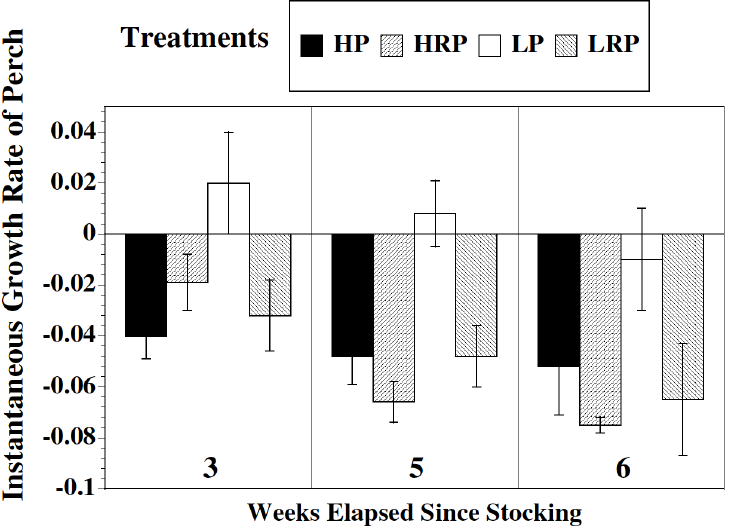
Figure 1. Mean instantaneous growth rate (plus or minus one standard error) by treatment, of yellow perch after three, five, and six weeks in the mesocosms. There were four replicates of each treatment except LRP ( n = 3). HP = 28 perch, HRP = 14 perch + 14 ruffe, LP = 14 perch, and LRP = 7 perch + 7 ruffe.